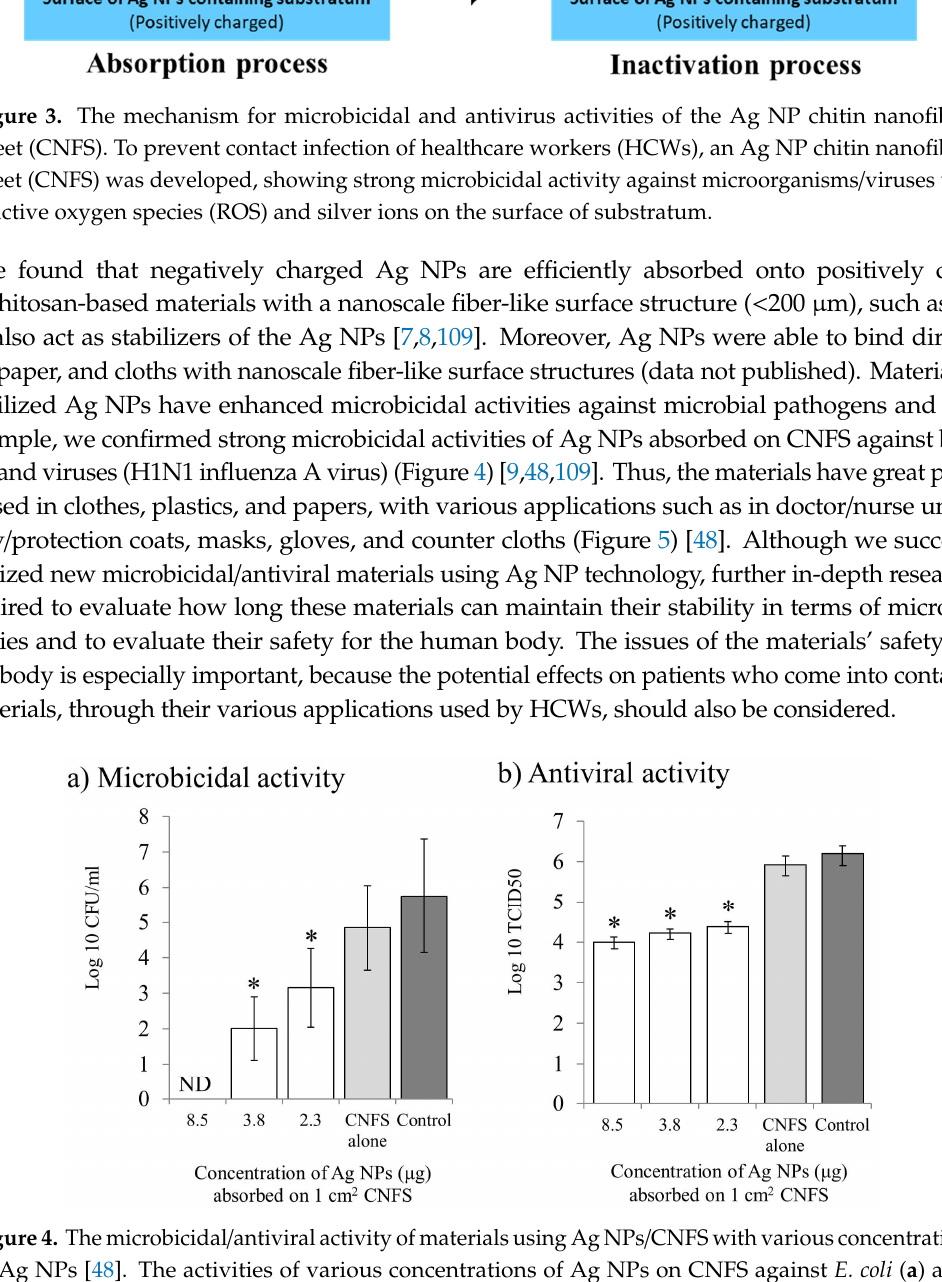
Figure 5. The application of the Ag NP/CNFS complex to protect HCWs. To prevent contact infection of HCWs, we have proposed medical consumables, such as infection-protective coats, masks, and gloves, immobilized Ag NPs. 7. Other Medical Applications Some of the commercially available silver-based materials already available are shown in Table 3. The range of microbicidal properties of Ag NPs is wider than that of antibiotics, and the appearance of resistant bacteria such as MRSA is rare in Ag NP-based materials [115]. The combination of various materials with Ag NP-based materials has been studied [116–119]. The production of wound dressings and medical catheters coated with Ag NPs has been investigated. However, silver absorbed by the skin causes food poisoning symptoms [120]. Moreover, metal allergies can be triggered if Ag NPs stay in the body for a long time [121]; therefore, care must be taken to avoid their intake.